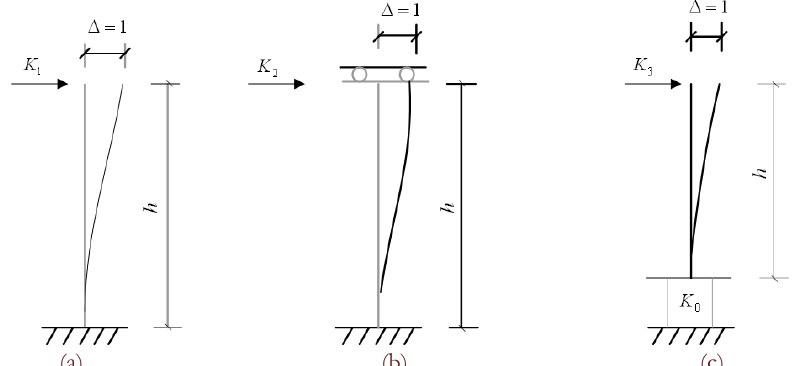
Figure1: The schematic diagram of lateral stiffness meaning for different rotational restraint components on both upper and lower end: (a) The top is free and the bottom is fixed; (b) The top is sliding and the bottom is fixed; (c) The top is sliding and the bottom is spring